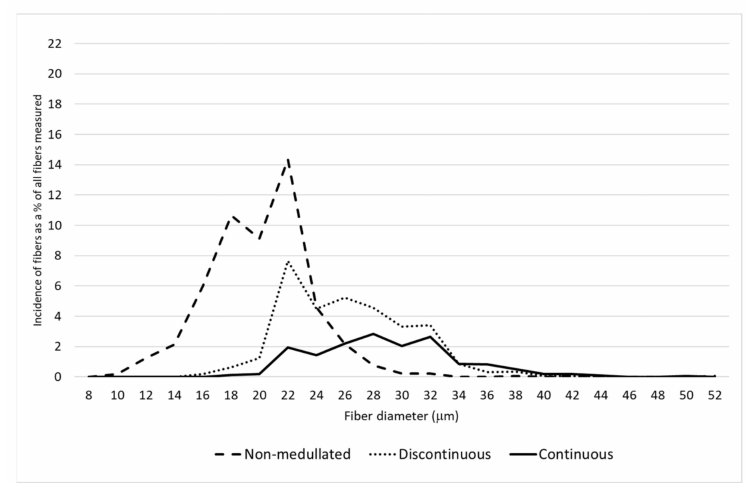
Figure 3. The distribution of each fiber category for the neck.